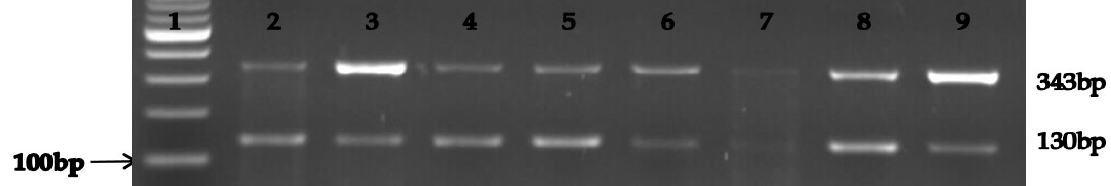
Figure 3. PCR products of the amplification of pehX ( K. oxytoca ) and magA genes ( Klebsiella pneumoniae ). Lane1: 100 bp molecular weight marker; Lanes 2–9: positive isolates. Band size: 343 bp ( K. oxytoca ); 130 bp ( K. pneumonia ). Table 3. Number of confirmed Klebsiella spp. isolated from di ff erent sample